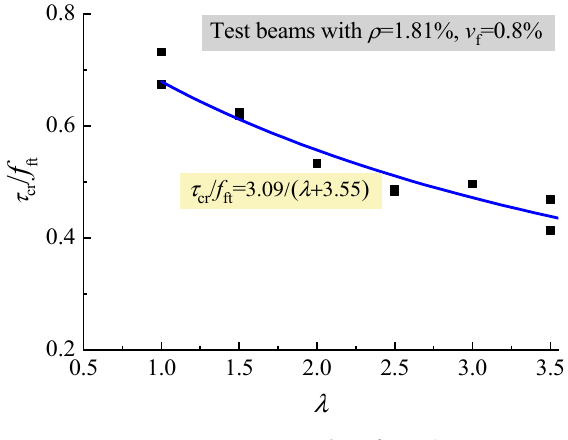
Figure 8. Variations of τ cr / f ft with λ .